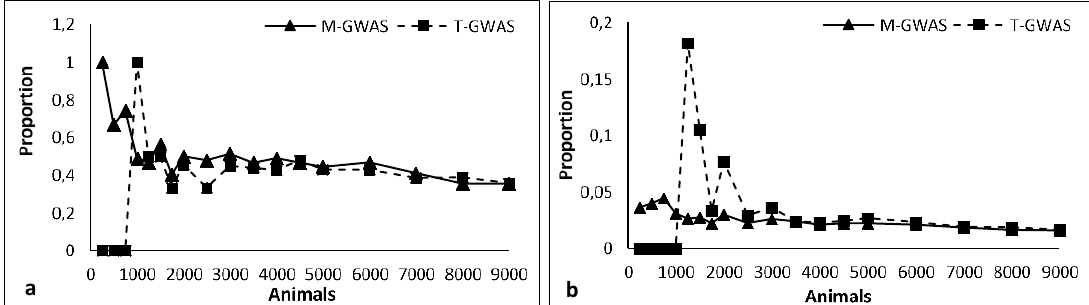
Figure 1. The proportion of detected QTLs with respect to the true associated ( a ) and false associated ( b ) markers for both multivariate (M-GWAS) and traditional (T-GWAS) GWAS as the number of involved animals increases.